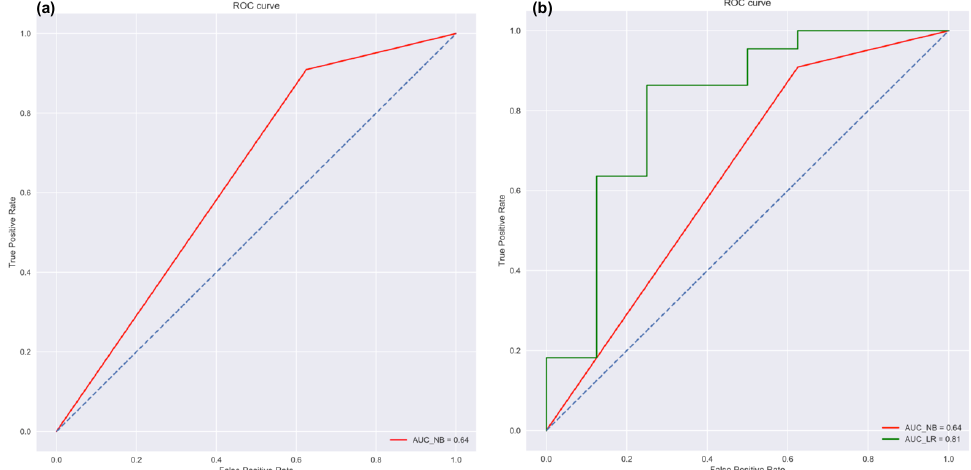
Figure 7. NB Classifier output: ( a ) ROC curve showing AUC for NB and ( b ) plot comparing AUC for NB and logistic